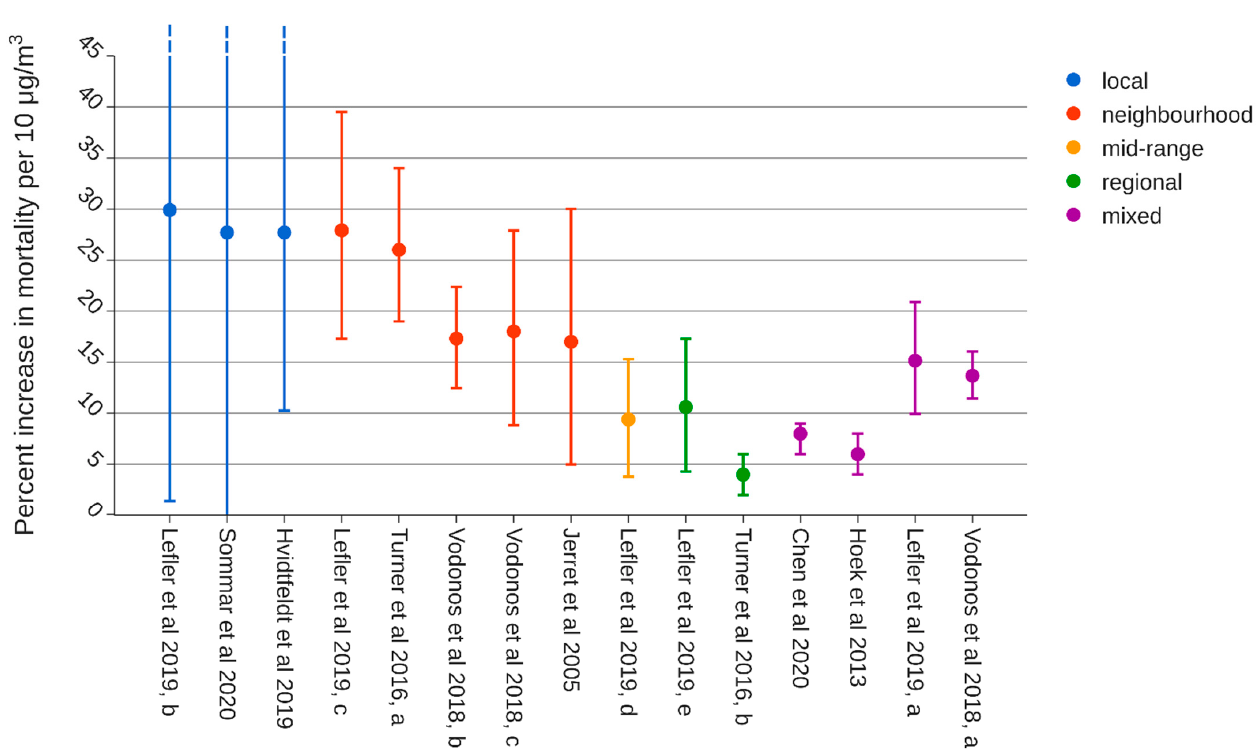
Figure 4. Percent increase in mortality per 10 μ gm − 3 PM 2.5 categorized by spatial resolution of exposure data. “Local” corresponds to <1 km resolution, “neighborhood” to 1–10 km, “mid-range” to 10–100 km, and “regional” to >100 km. Confidence intervals (95%) are shown as dashed where outside the scale. In the figure, the estimate denoted as “near-source” by Turner et al. [28] is categorized as the neighborhood scale. The data presented in the figure can be found in Table A1.